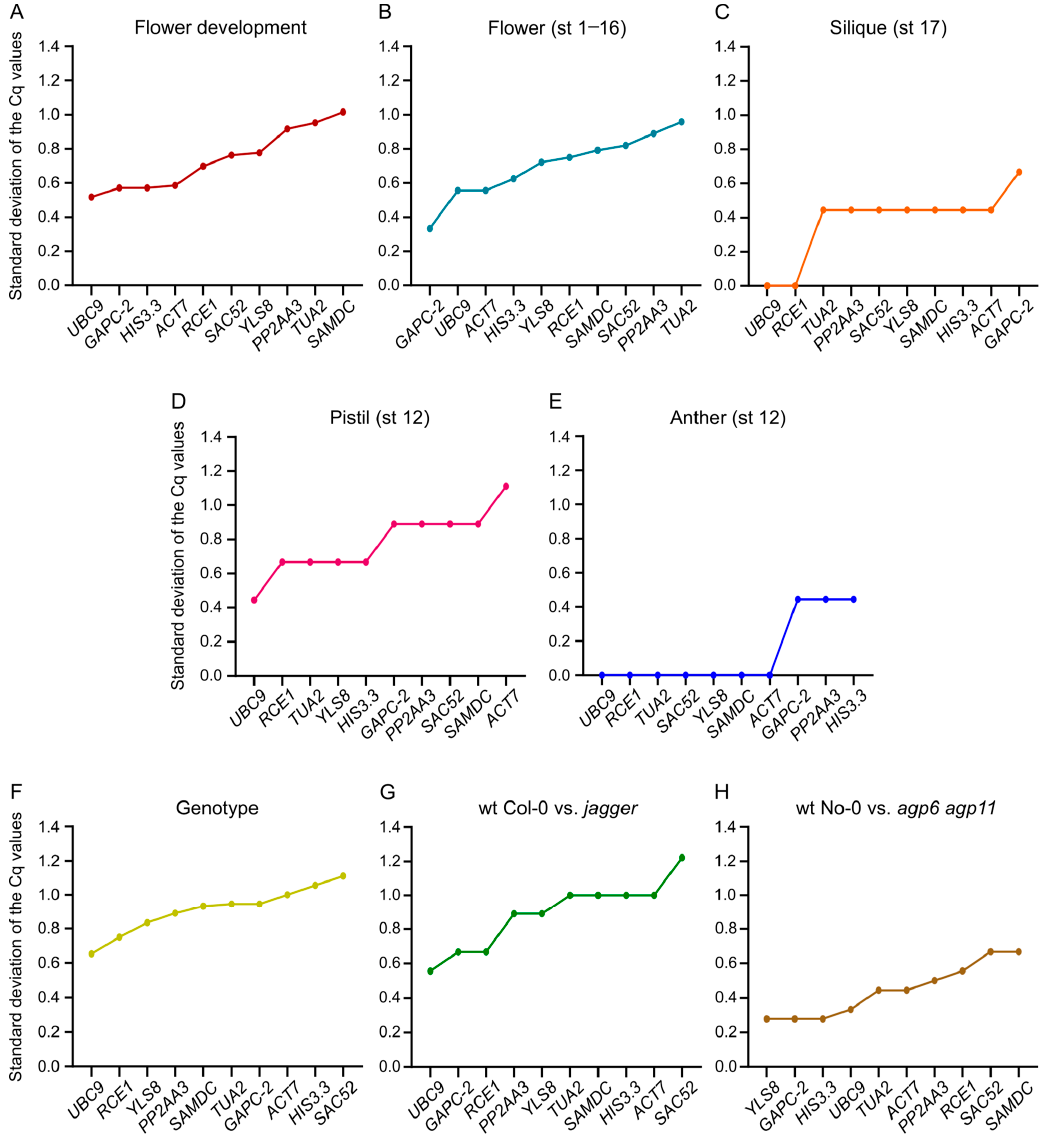
Figure 5. Standard deviation (SD) of the Cq values of ten candidate reference genes calculated by BestKeeper in the RefFinder software. ( A ) SD values of the ten candidate reference genes in the flower development group which included 21 samples corresponding to flower (st 1–16), silique (st 17), pistil (st 12), and anther (st 12) samples. ( B ) SD values of the ten candidate reference genes in 12 flower (st 1–16) samples which included flower st 1–6, flower st 7–12, flower st 13–14, and flower st 15–16 samples. ( C ) SD values of the ten candidate reference genes in the three silique (st 17) samples. ( D ) SD values of the ten candidate reference genes in the three pistil (st 12) samples. ( E ) SD values of the ten candidate reference genes in the three anther (st 12) samples. ( F ) SD values of the ten candidate reference genes in the genotype set that comprised 12 samples corresponding to wt Col-0, jagger , wt No-0 and agp6 agp11 samples. ( G ) SD values of the ten candidate reference genes in six wt Col-0 vs. jagger samples that included three wt Col-0 and three jagger samples. ( H ) SD values of ten candidate reference genes in six wt No-0 vs. agp6 agp11 samples which included three wt No-0 and three agp6 agp11 samples. The genes are arranged from the most to the least stable gene (from left to right). Abbreviations: Col-0, Columbia-0; No-0, Nossen-0; st, stage; wt,